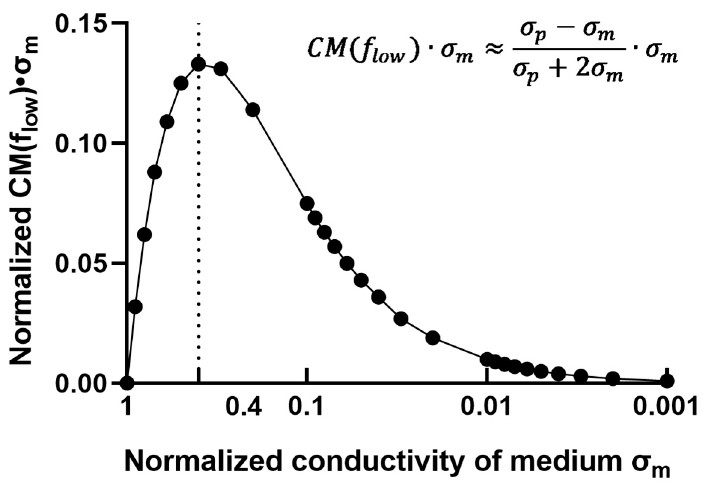
Figure 7. Normalized Clausius–Mossotti (CM) factor multiplied by conductivity of the medium versus normalized conductivity of medium in the low frequency range below 100 MHz. The con- ductive behavior dominates the value of the CM factor and the DEP force is attractive (see [44], their Section 2.4.1).